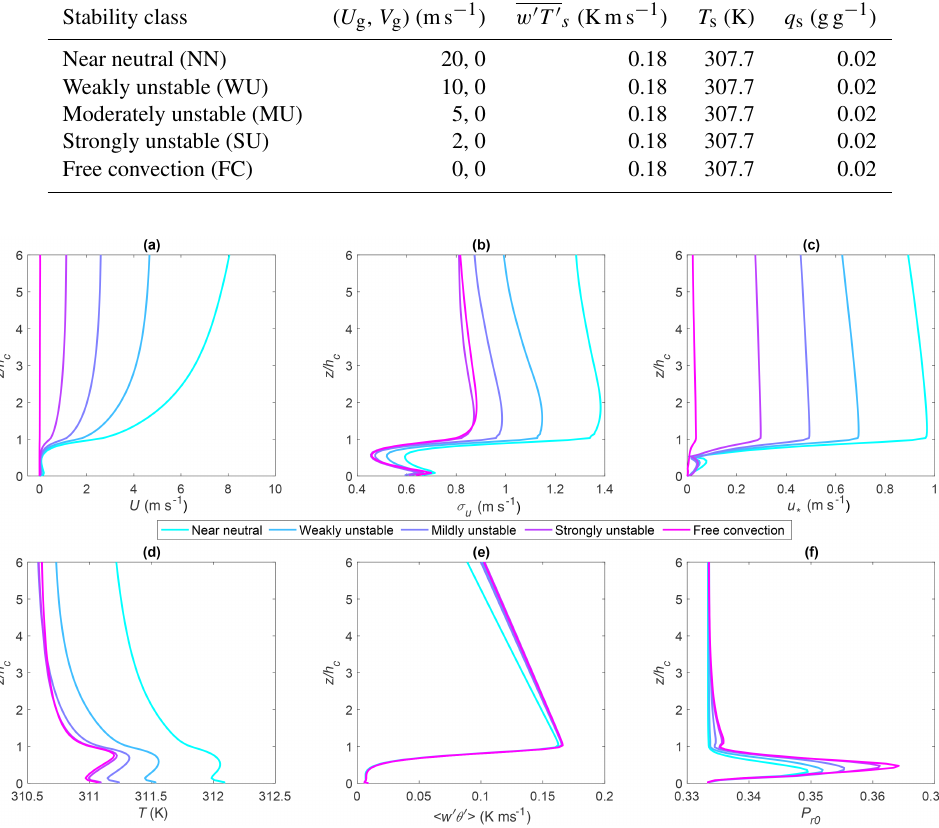
Figure 1. Summary statistics of five LES simulations showing the variations between different stability classes in increasing order of insta- bility – from near neutral to free convection color coded as indicated in the